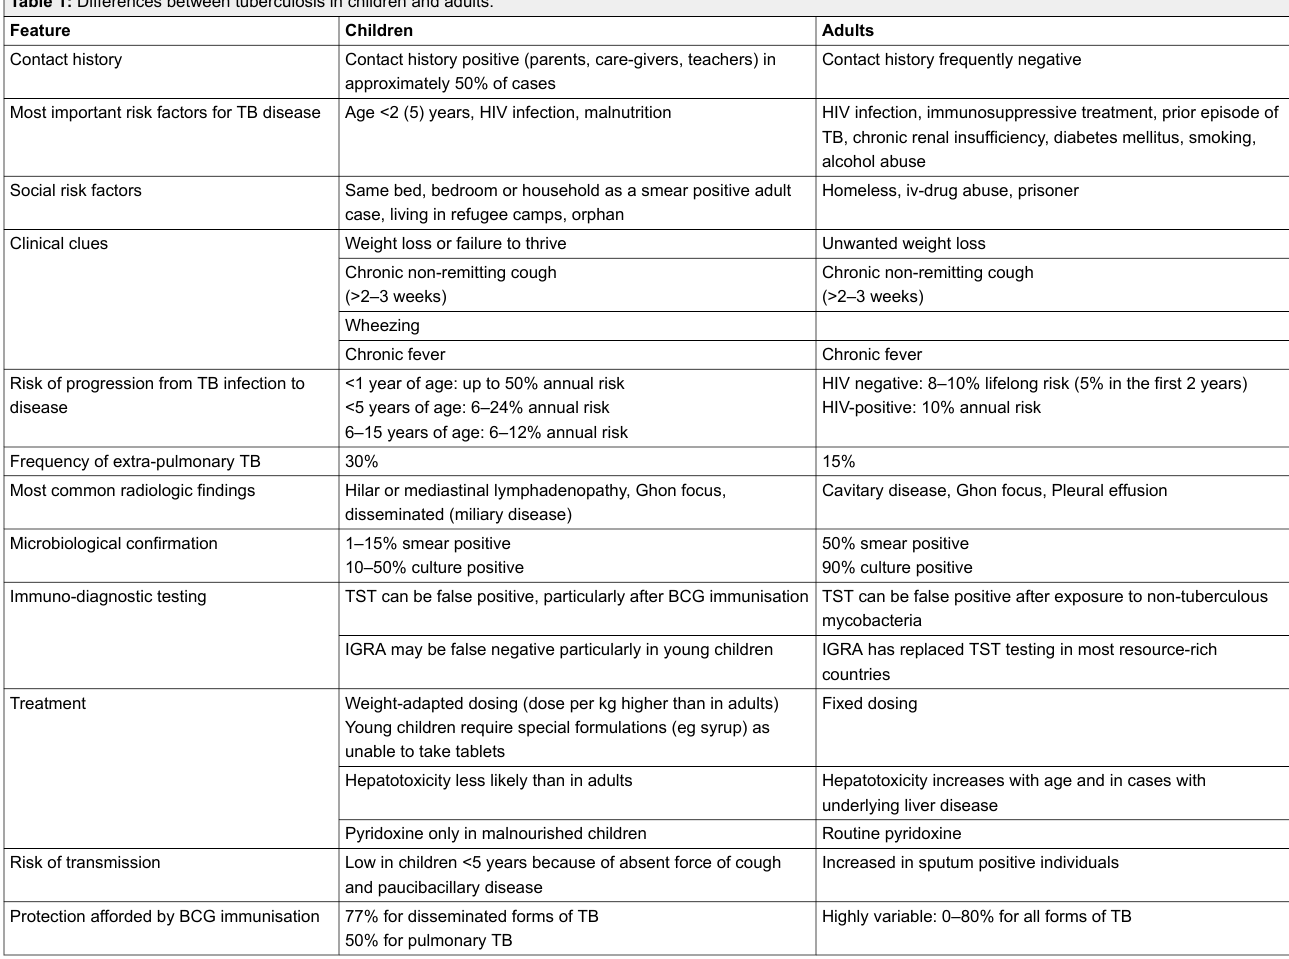
Table 1: Differences between tuberculosis in children and